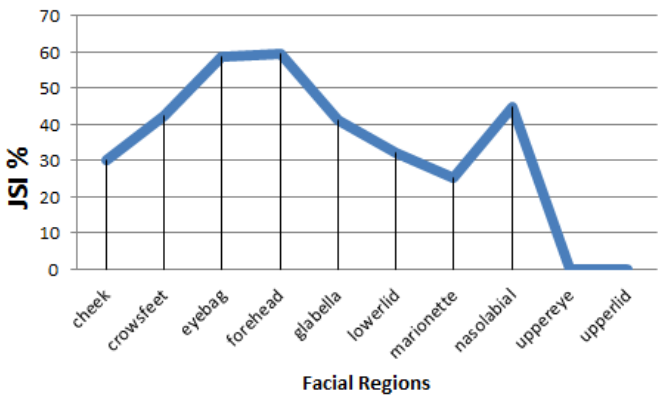
Figure 6. Average JSI of automatic wrinkle detection for ten face